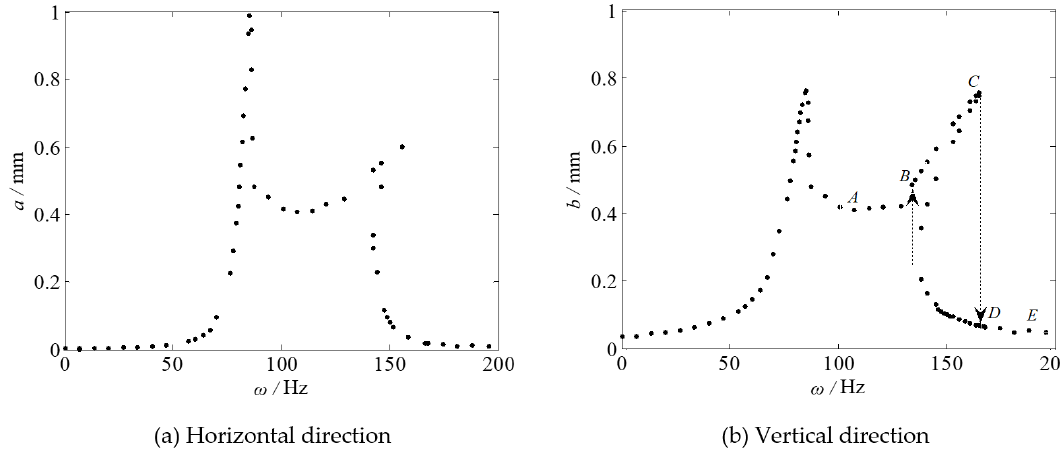
Figure 12. Amplitude–frequency curve of the coupled vibration system of the hot rolling mill with external disturbing force F = 4 × 10 5 N. ( a ) Amplitude–frequency curve of horizontal direction; ( b ) Amplitude–frequency curve of vertical direction.